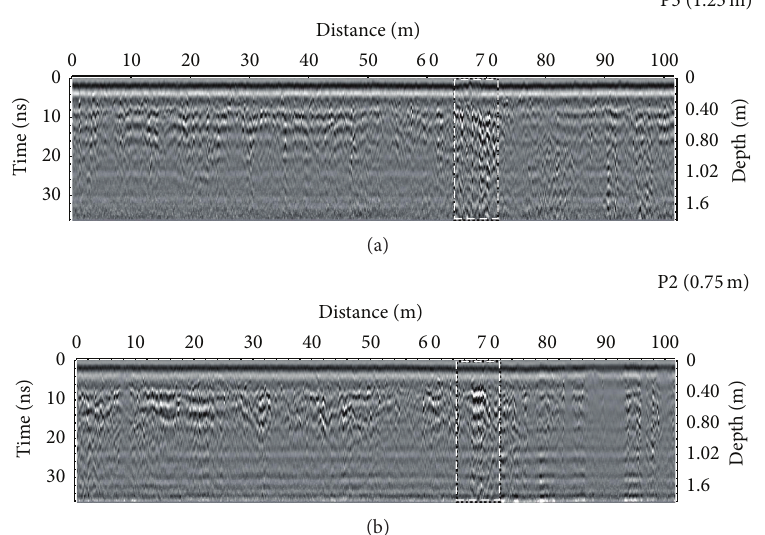
Figure 12: Possible seepage area detected with the 400 MHz GPR on the paved revetment, associated with the 20 m downstream leakage area: (a) profile P3 at 1.25 m high; (b) profile P2 at 0.75 m